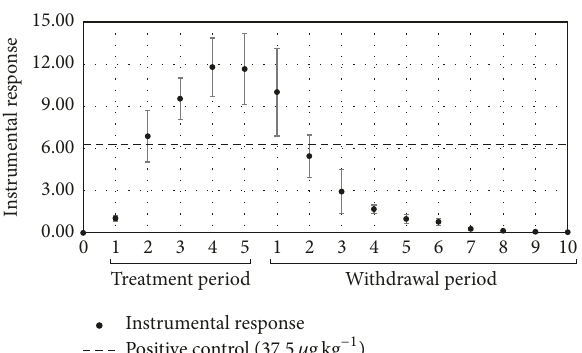
Figure 3: Residues of lincomycin in egg samples from layer hens subjected to a pharmacological treatment with lincomycin, during the drug administration period and days of residual evaluation.